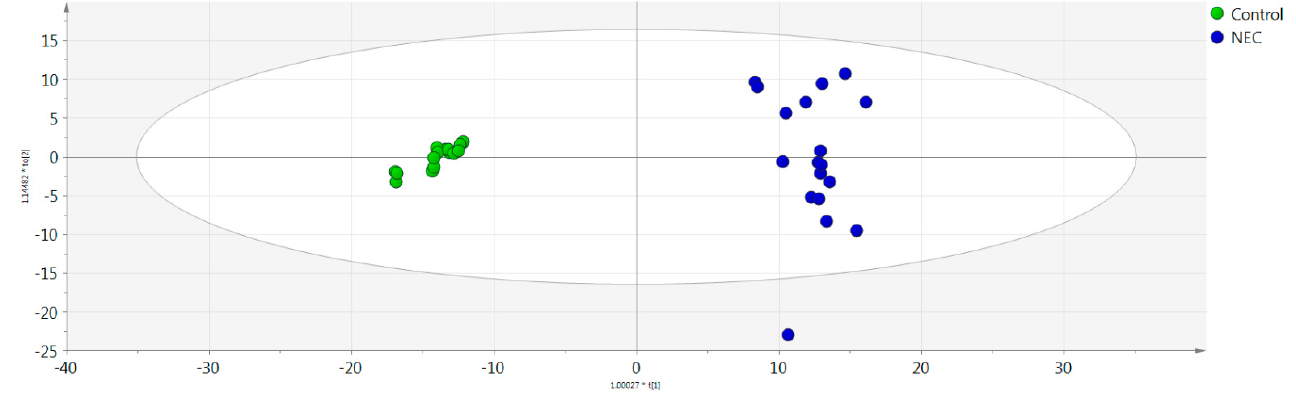
Figure 4 . Box plots of significant metabolites in the control and necrotizing enterocolitis (NEC) groups. 3.2.3. Metabolites Identification Lipid (tentative) identification was performed utilizing high-resolution mass spectra in MS and MS mode and aimed at recognizing head groups and lipid species. (Lyso)PCs can be identified in positive ionization mode as sodium and potassium adducts as well as in their protonated cationic form. Among the statistically significant features, lipids com- prising the class of phosphatidylcholine(s) (PC)s were mainly identified covering different polarities. Identification was performed by a combination of either automatic and/Tor manual data manipulation and library searching. For all identified PCs, a characteristic head-group fragment m/z 184.0739 (C5H15NO4P+) was observed. In Figure 5, an example of a manually annotated PC is presented.